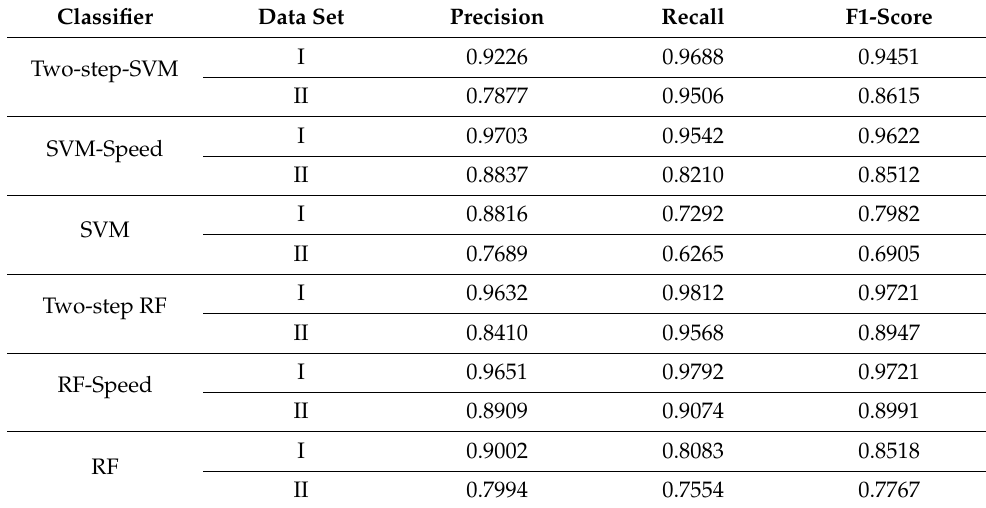
Table 6. Quantitative results of different pedestrian